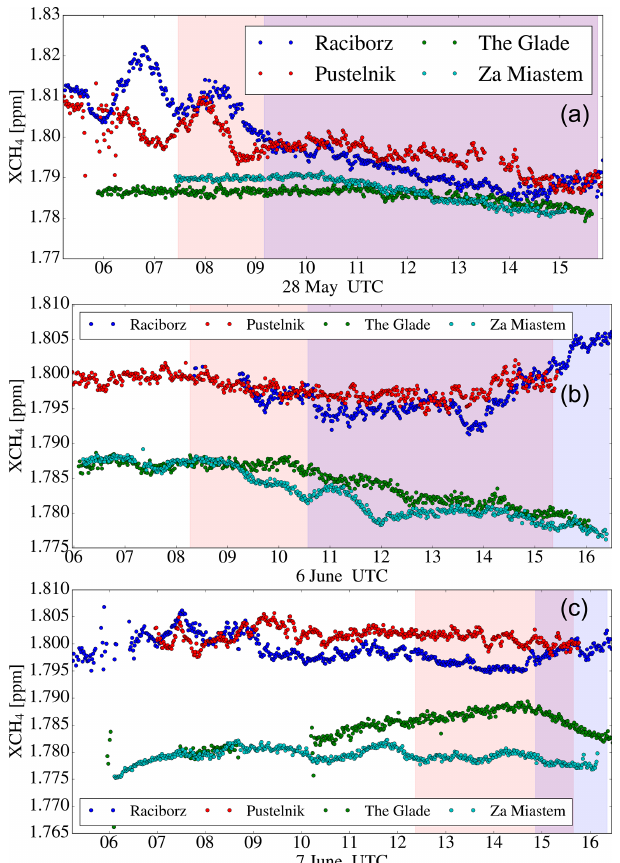
Figure 7. XCH 4 for 28 May (a) , 6 June (b) , and 7 June (c) 2018 at the stations Raciborz (W, blue), Pustelnik (S, red), The Glade (E, green), and Za Miastem (N, cyan). Background shadings indicate the time frames used for further analysis considering the individual travel times (light red for Pustelnik – S, blue for Raciborz – W, purple for both Raciborz and